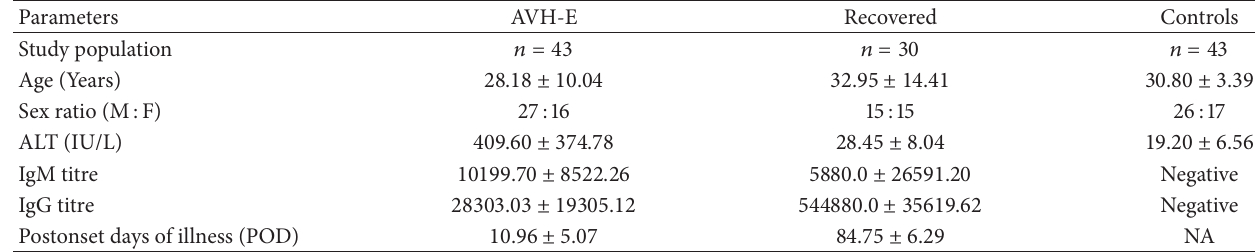
Table 1: Characteristics of study